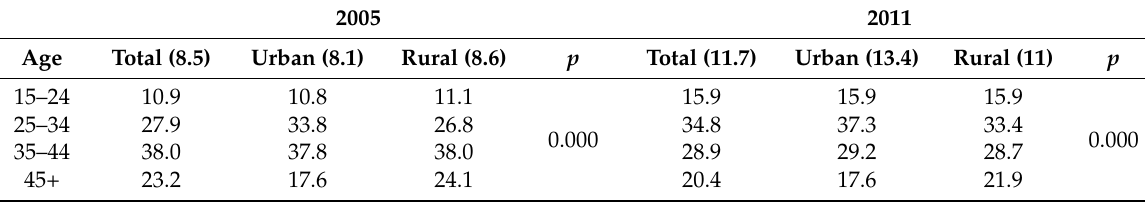
Table 1. Trends in the prevalence (%) of smoking among men aged 15 years and above in Ethiopia. Ethiopia Demographic and Health Survey.